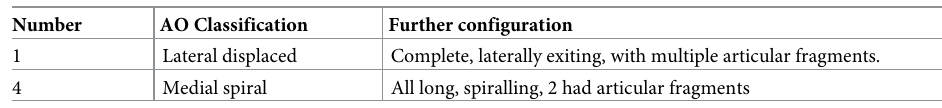
Table 4. Metatarsal bone fractures.